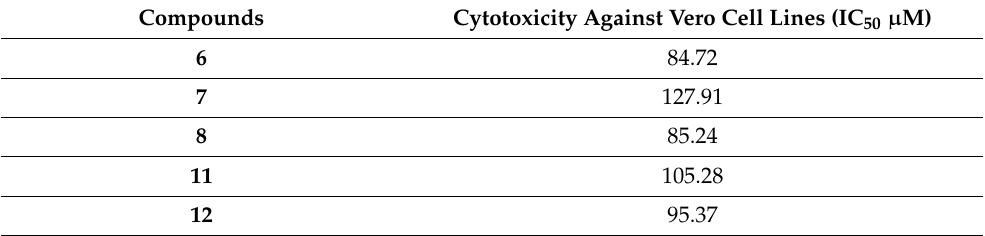
Table 2. In vitro anti-proliferative activities of compounds 6 , 7 , 8 , 11 , and 12 against Vero cell lines.